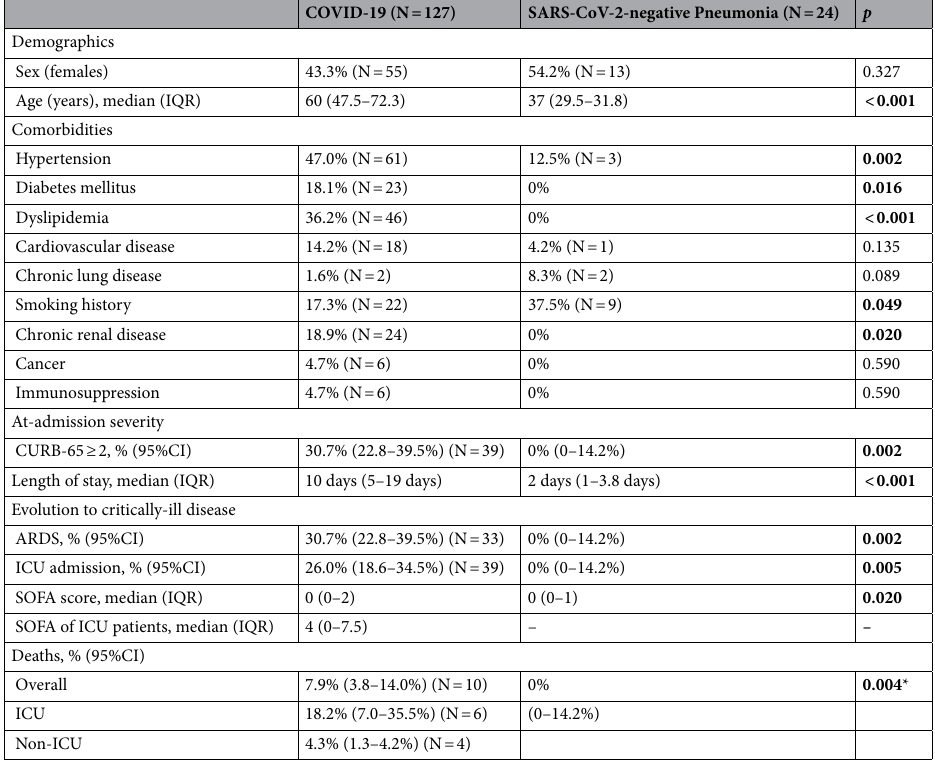
Table 1. Demographic and clinical characteristics of patients with COVID-19 and SARS-CoV-2 negative pneumonia. Bold values denote statistical significance at the p < 0.05 level. ARDS acute respiratory distress syndrome, ICU intensive care unit, IQR interquartile range, SOFA score Sequential organ failure assessment score. * p value of Chi-Squared test for 3 categories (COVID-19 ICU and non-ICU and SARS-CoV-2-negative Pneumonia) and p value of 0.019 for deaths in ICU vs. non-ICU COVID-19